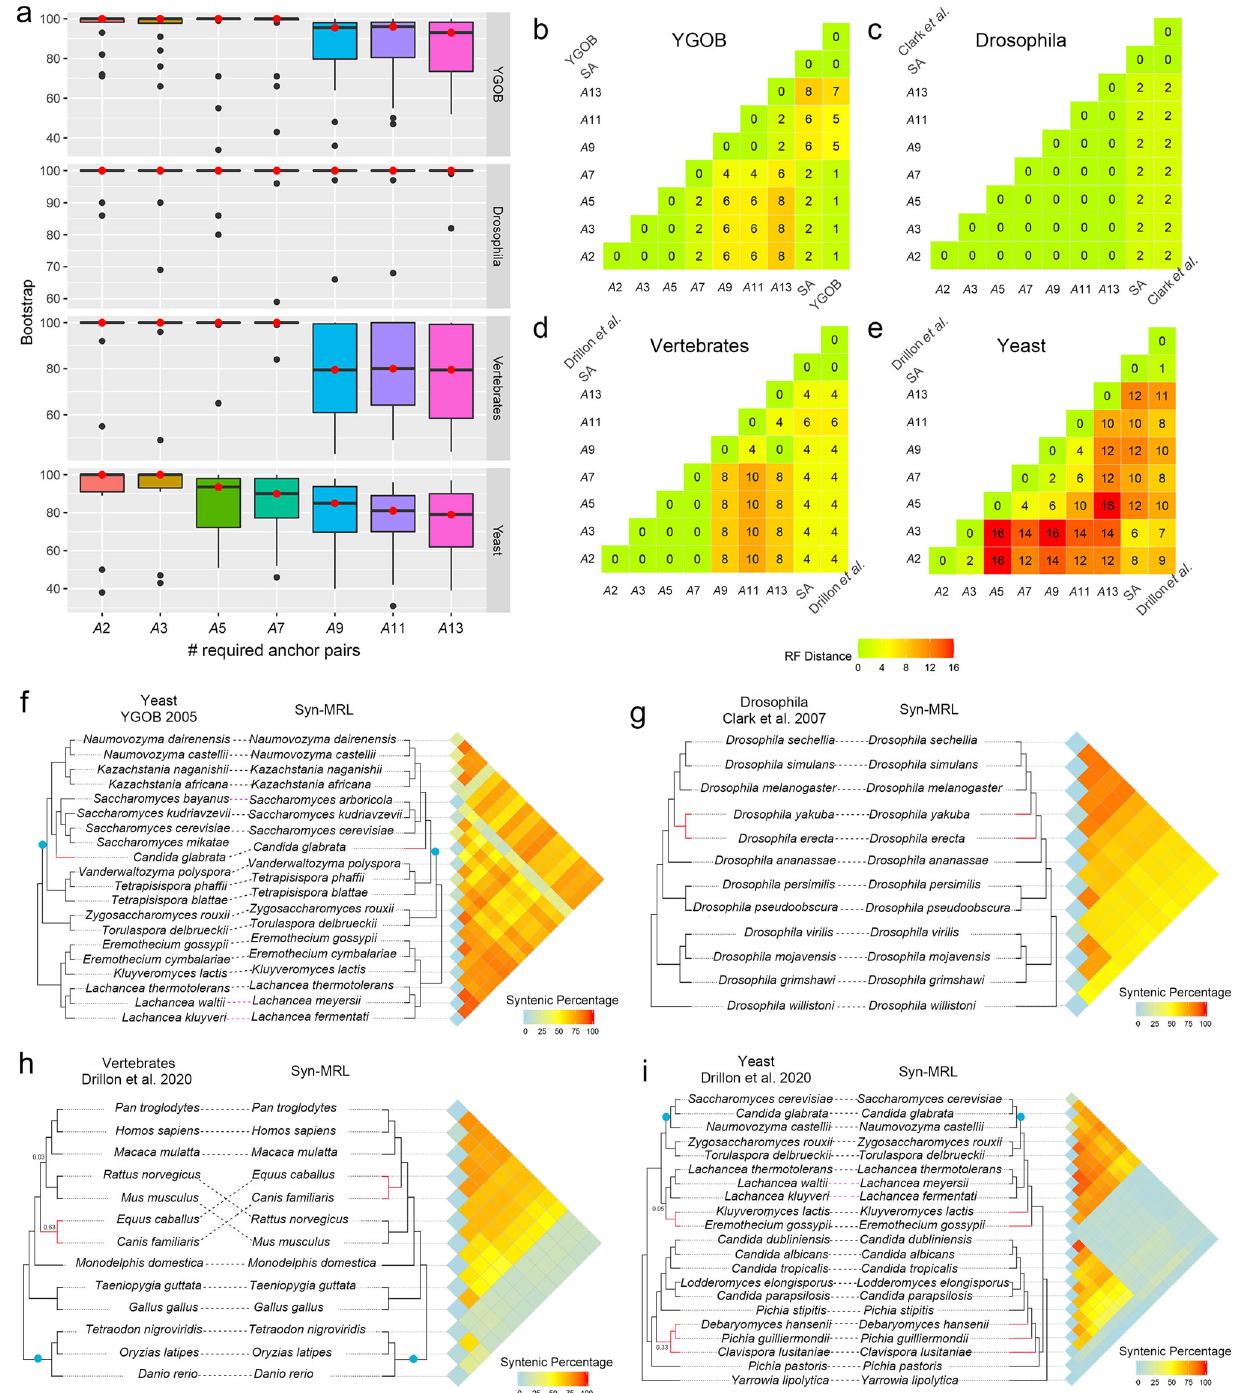
Fig. 3 Results of Syn-MRL on empirical data sets. a Distribution of the support values of all the nodes of the inferred trees for the four data sets under different settings of A min (the number of required anchor pairs for regions to be called syntenic). The boxplots indicate the minimum, maximum, median (the middle hinge with red dots), fi rst quartile (the lower hinge), and third quartile (the upper hinge) in the data sets ( n = 16, 9, 10, and 18 for the data sets of YGOB, Drosophila , vertebrates, and yeast). The whiskers represent the 1.5 inter-quartile range (IQR) extending from the hinges and outliers are shown as individual points. b – e Pairwise RF distances of the inferred trees, sequence alignment-based tree, and the reported tree of the data sets of YGOB, Drosophila , vertebrates, and yeast, respectively. Note that for the yeast data set, the species ‘ Yarrowia lipolytica ’ (used as the root of the tree) was absent from the data matrices at A 11 and A 13 (no synteny detected), and we therefore manually added this species (as the root) to the inferred tree, in order to calculate the RF distances. f – i Tree comparisons between the reported tree and the Syn-MRL tree of YGOB, Drosophila , vertebrates, and yeast data sets, at parameter setting values of A 5 G 25 , A 5 G 25 , A 5 G 6 , and A 2 G 25 , respectively. Matrices of syntenic percentages of pairwise genome comparisons are aligned to the corresponding species. Each cell of the matrix represents an overall syntenic percentage of a genome comparison, which is calculated using the total number of syntenic genes relative to the total number of genes between two genomes. The color indicates the values and goes from low (blue) to high (red). Different branching patterns are highlighted in red, genome duplication events are labeled as blue dots. Branch lengths are not meaningful. Support values for certain nodes of the vertebrate and yeast trees are from Drillon et al. 16 .